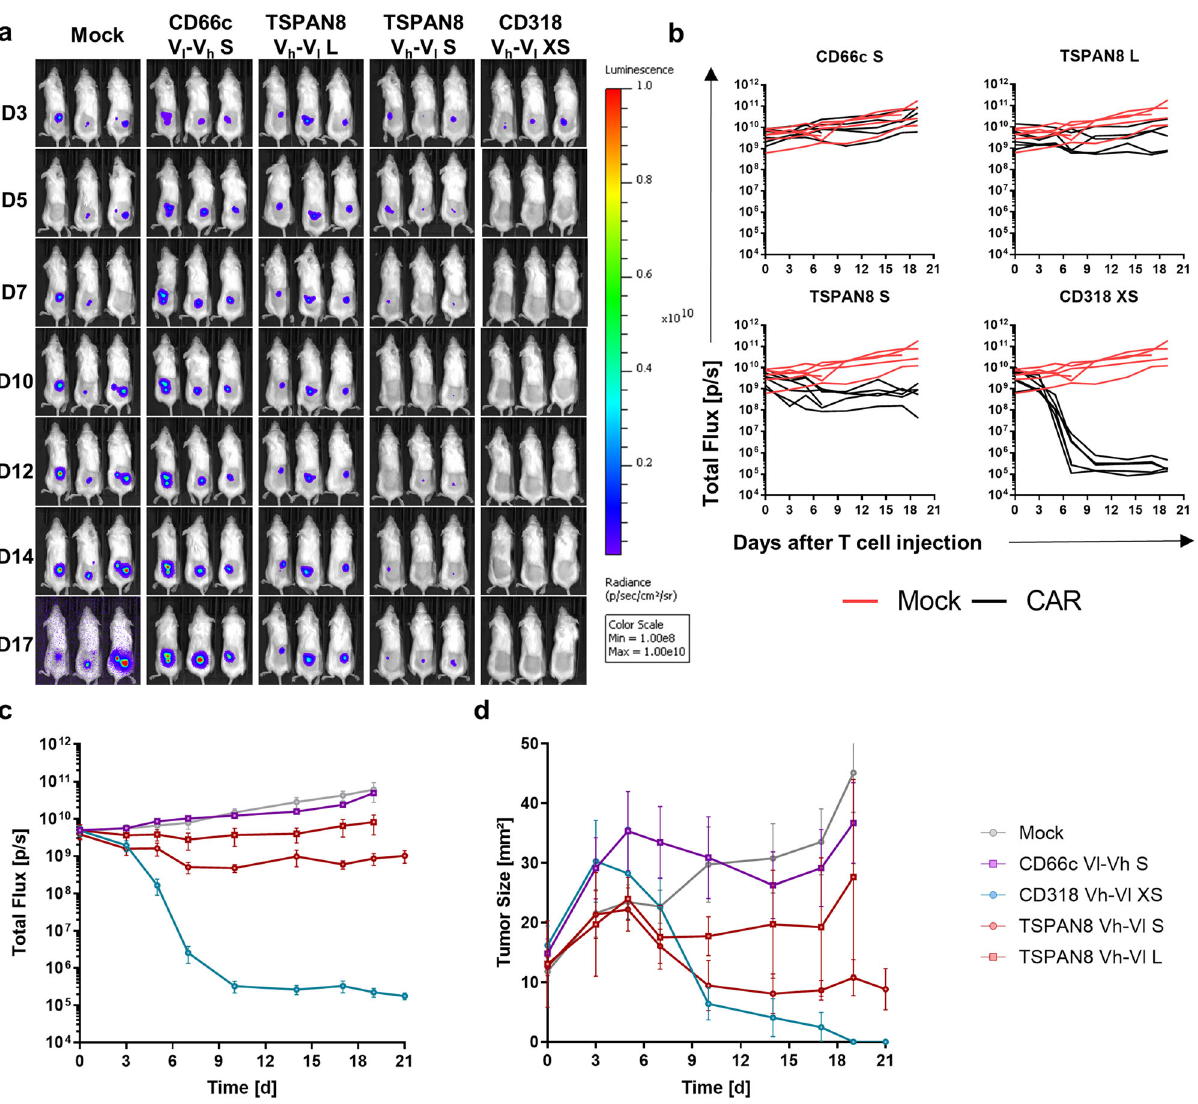
Fig. 6 Evaluation of CAR T cell in vivo functionality in a BxPC3 xenograft model. a Representative bioluminescence images of tumor-bearing NSG mice. Tumors were induced by subcutaneously transplanting luciferase expressing BxPC3 (color scale for all images, min = 1 × 10 8 , max = 1 × 10 10 ). Mice were randomized and treated upon established solid tumors reached 25 mm² (day 15) by intravenous infusion of 1 × 10 7 CAR T cells or Mock T cells. b Development of tumor burden for individual mice treated either with Mock T cells or with the respective CAR T cells (Mock: n = 6, CD66c S: n = 6, CD318 XS: n = 6, TSPAN8 S: n = 6, TSPAN8 L: n = 6). c Average bioluminescence ± s.e.m. of the respective treatment groups ( n equal to b ). d Average tumor size ± s.e.m. of the respective treatment groups ( n equal to b ). Source data are provided as a Source Data fi